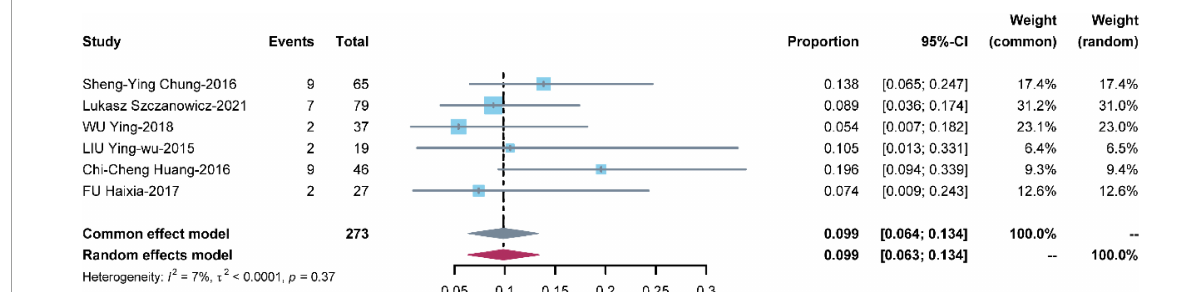
FIGURE5 Meta-analysis of the prevalence of cerebral infarction.